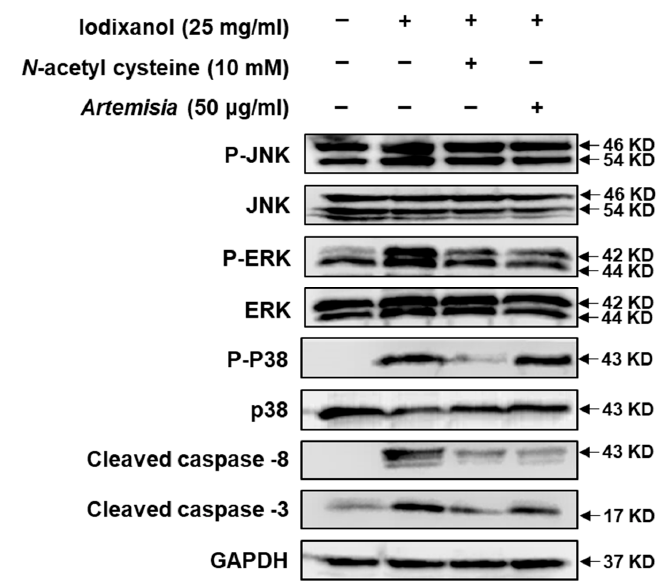
Figure 3. Effects of NAC and Artemisia argyi extract on MAPKs (p-JNK, JNK, p-ERK, ERK, p-p38, and